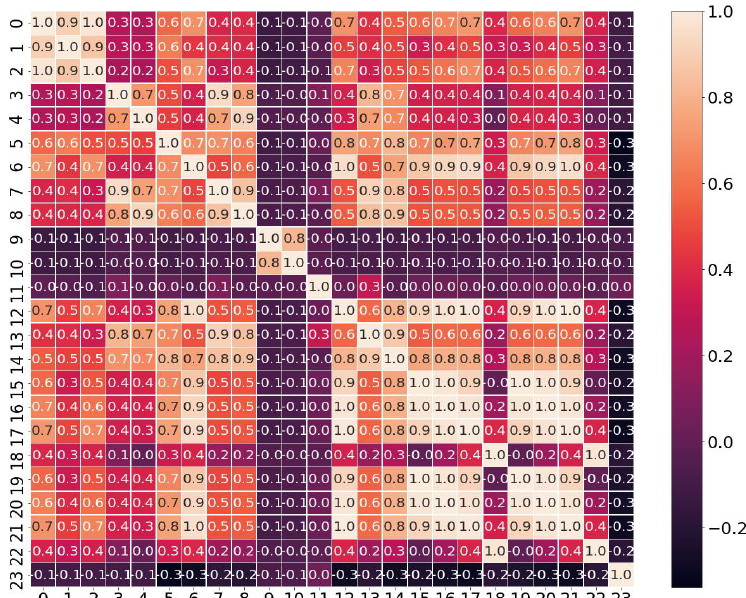
Figure 9. Importance of data features.